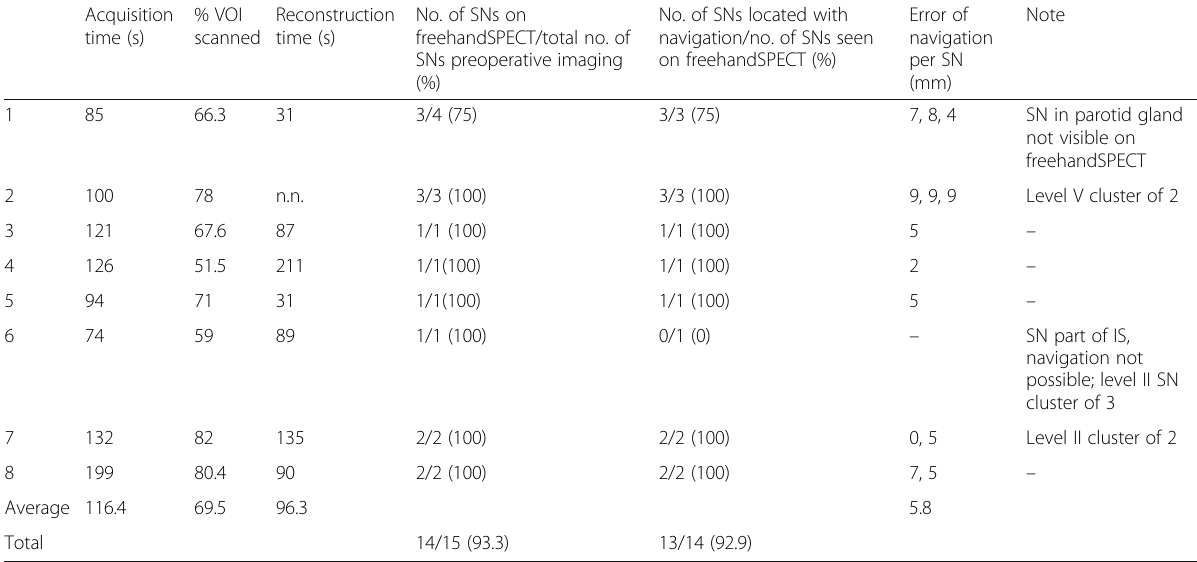
Table 2 Intraoperative freehandSPECT findings Acquisition time (s)